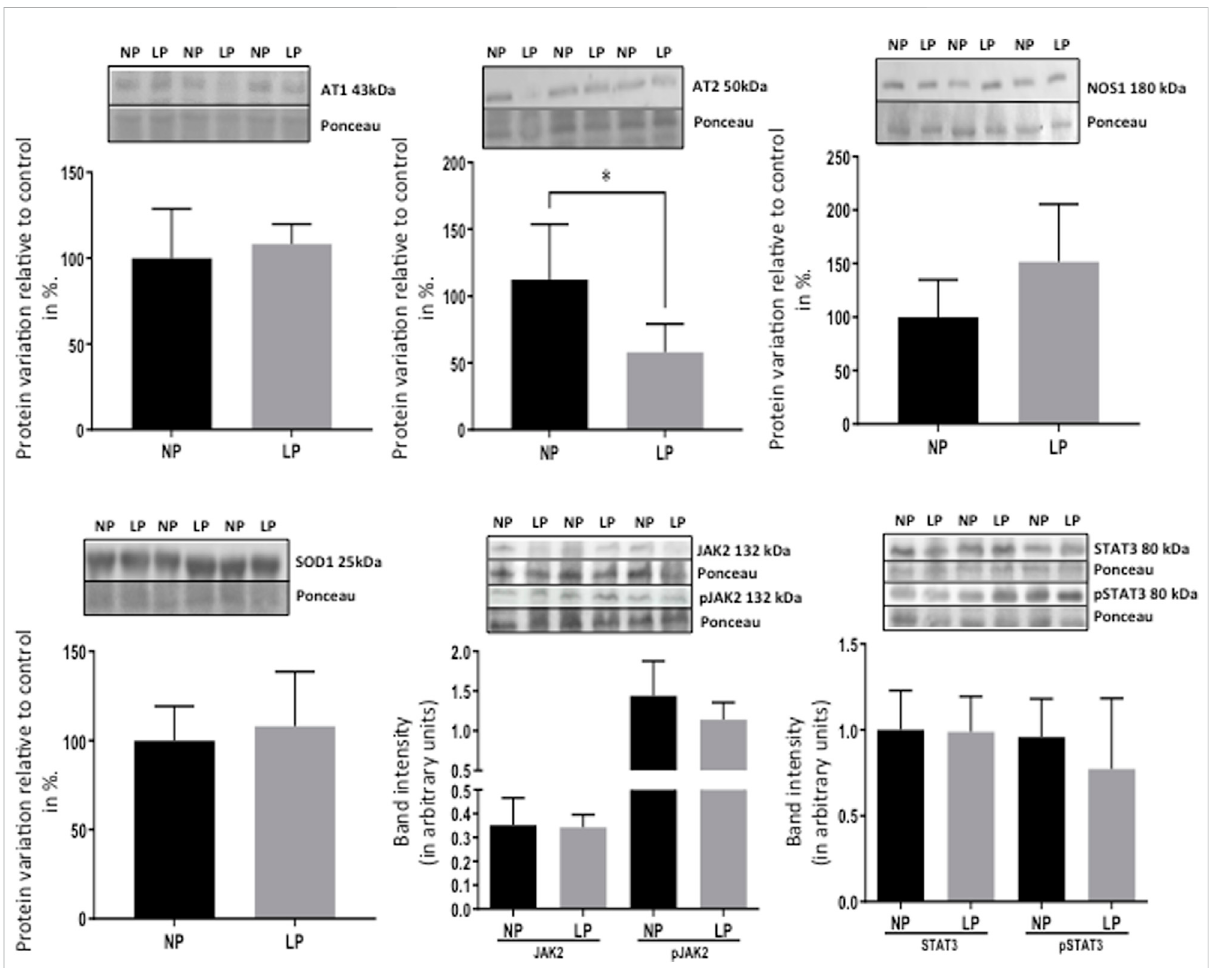
FIGURE 7 Effect of maternal protein restriction on AT1, AT2, NOS1, SOD2, JAK2, pJAK2, STAT3, and pSTAT3 proteins, measured using immunoblotting analysisintheisolatedLV.TheproteinvariationresultsfromLPprogenywereexpressedasmean±SDandrelativetocontrol(NPoffspring),assigning a value in %). The statistical analysis was performed by Student ’ s t-test when comparing only two samples of independent observations; only one offspring of each litter was used for immunoblotting experiments. *p <